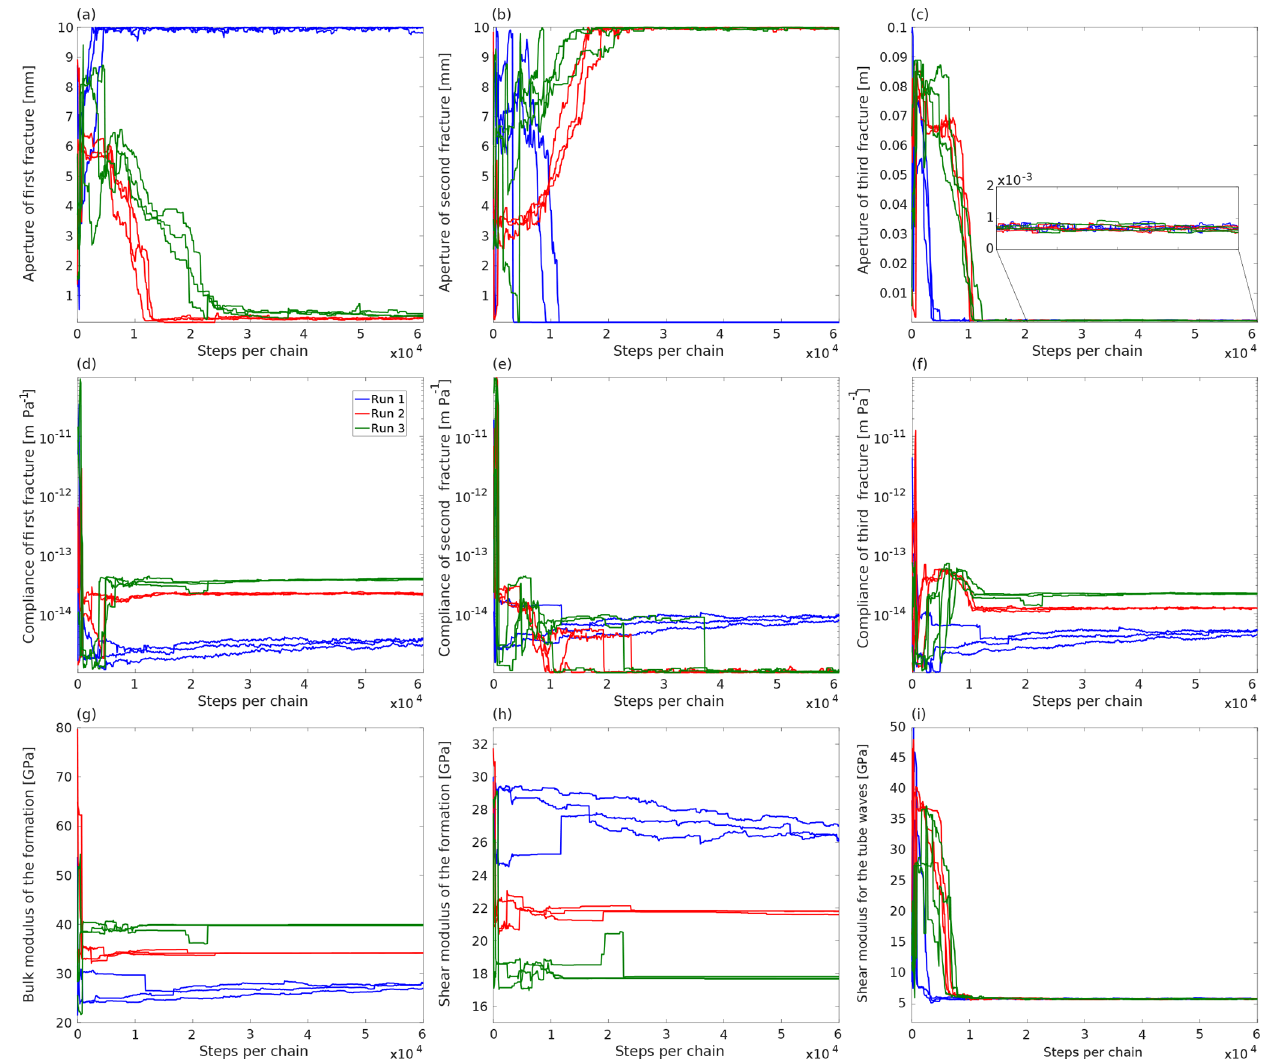
Figure 5. Development of the most relevant unknowns for the three MCMC inversion runs of the observed VSP data shown in Fig. 3: (a–c) apertures of the three fractures, (d–f) corresponding compliances, and (g–i) elastic